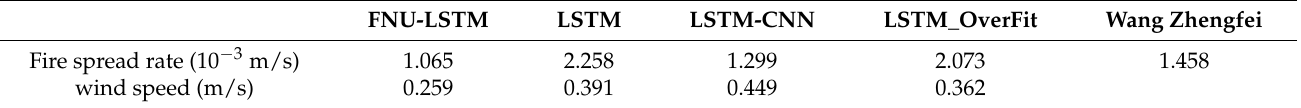
Table 9. The prediction error RMSE of fire spread rate (experimental